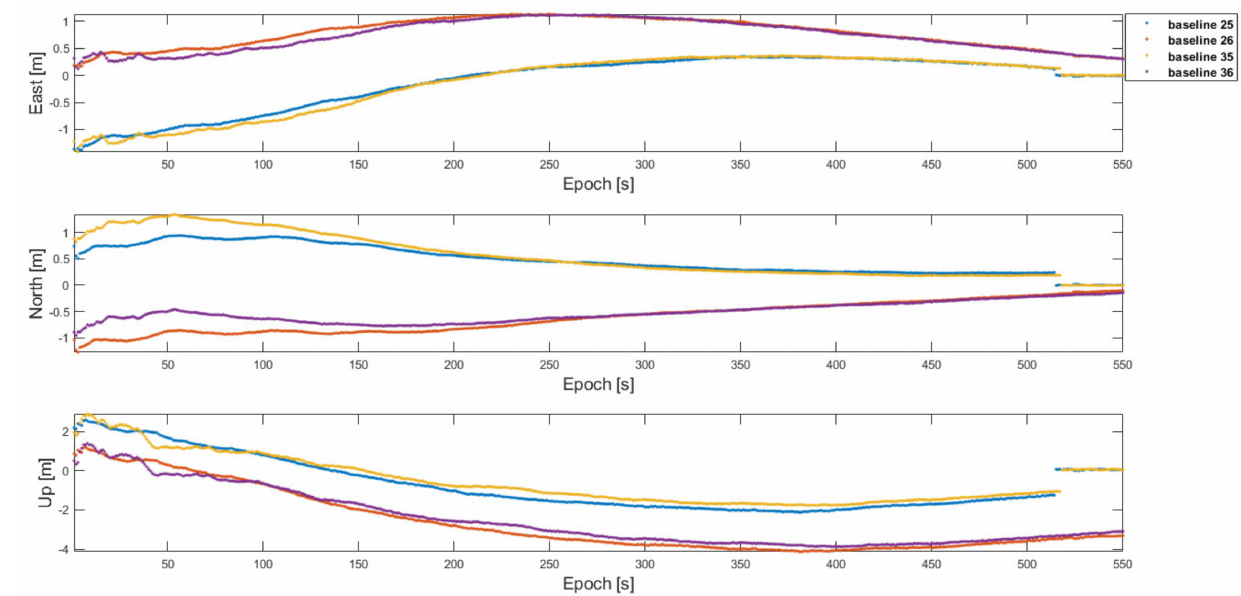
Figure 21. Position errors of the baselines across the cells with the one-to-one RTK using 6 common satellites in view in Figure 20.